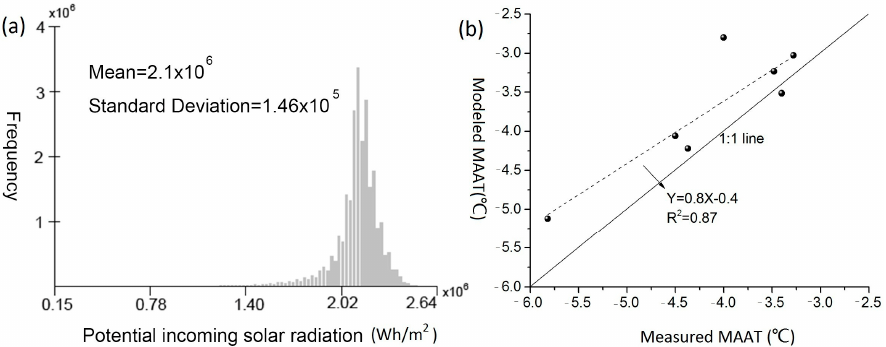
Figure 4. Frequency of the spatially-distributed potential incoming solar radiation in the QTEC ( a ), and relationship between measured MAAT and modeled MAAT. Y = modeled MAAT, X = measured MAAT ( b ). Table 4. Classification and field site identification accuracies for the land cover map.